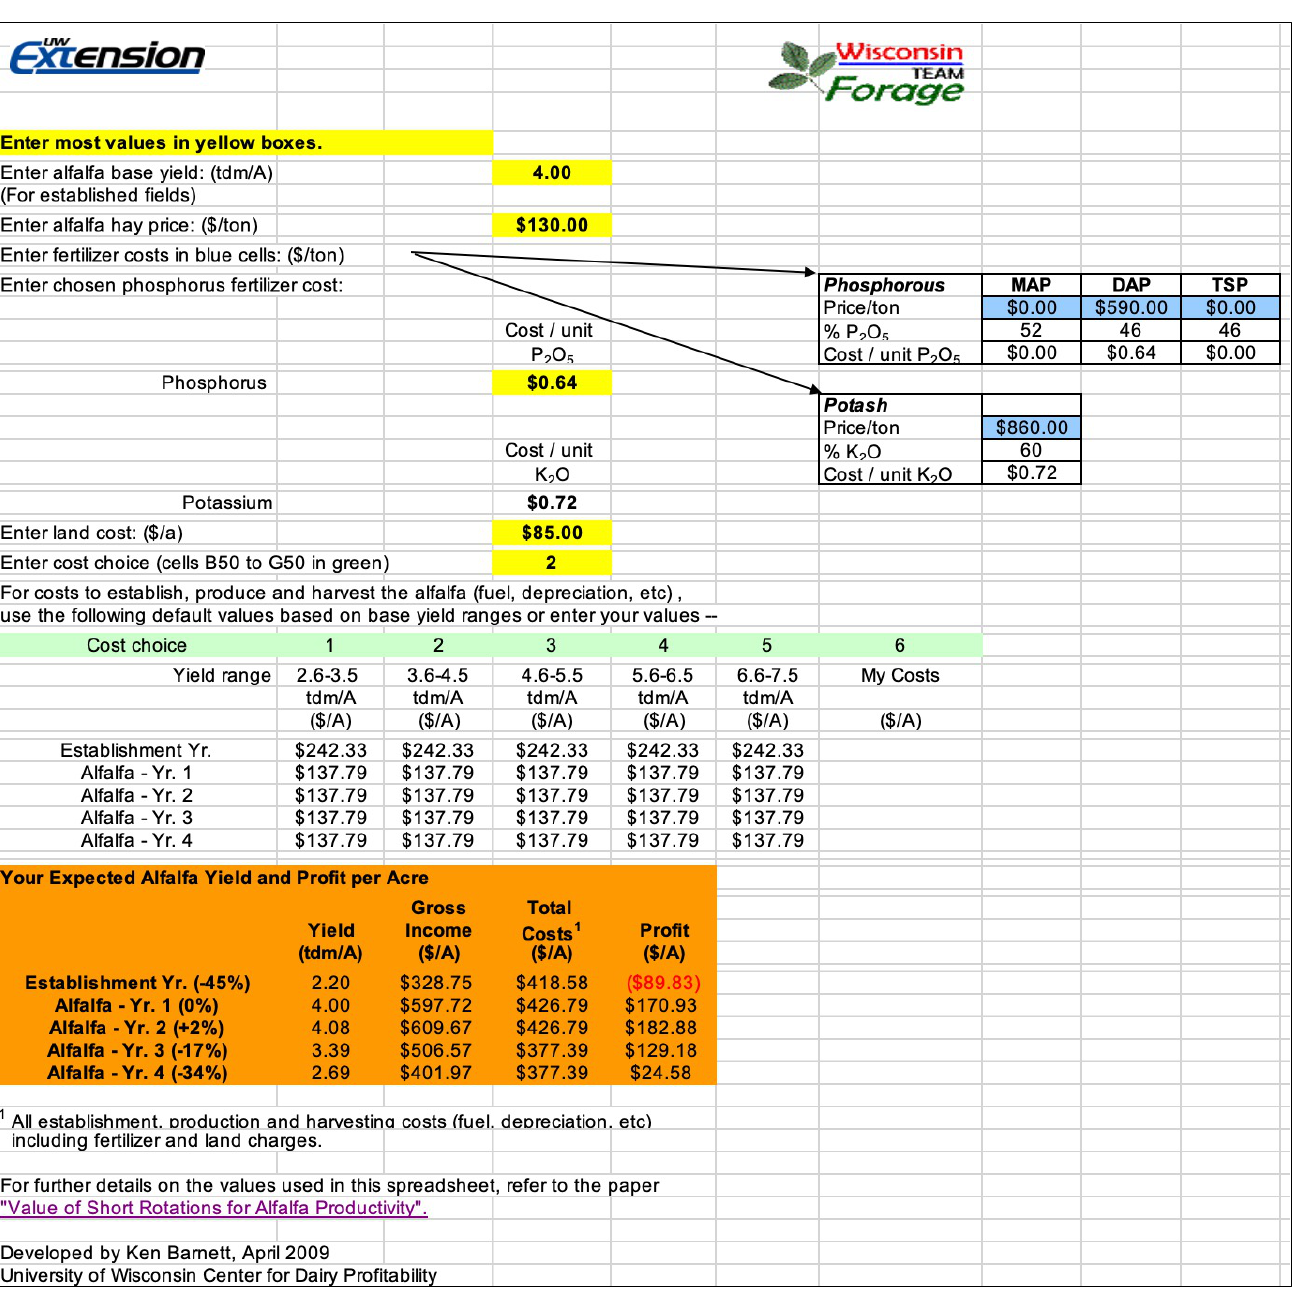
Figure 10. Alfalfa profitability and fertilizer cost calculator developed by University of Wisconsin- Extension. The yellow, light blue, and light green cells indicate user inputs, and the orange gener- ated